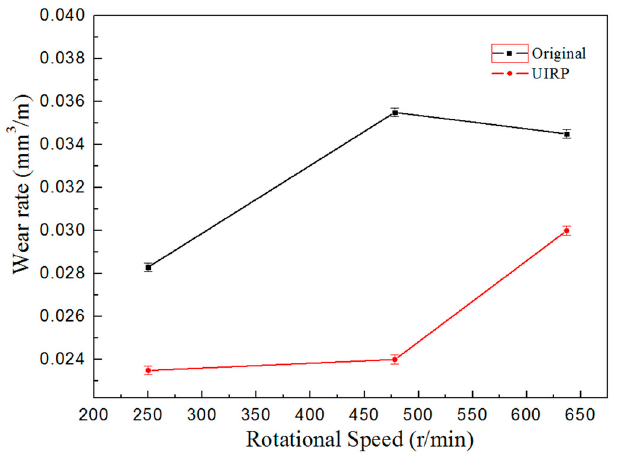
Figure 6. Comparison of wear rate between UIRP samples and original samples.